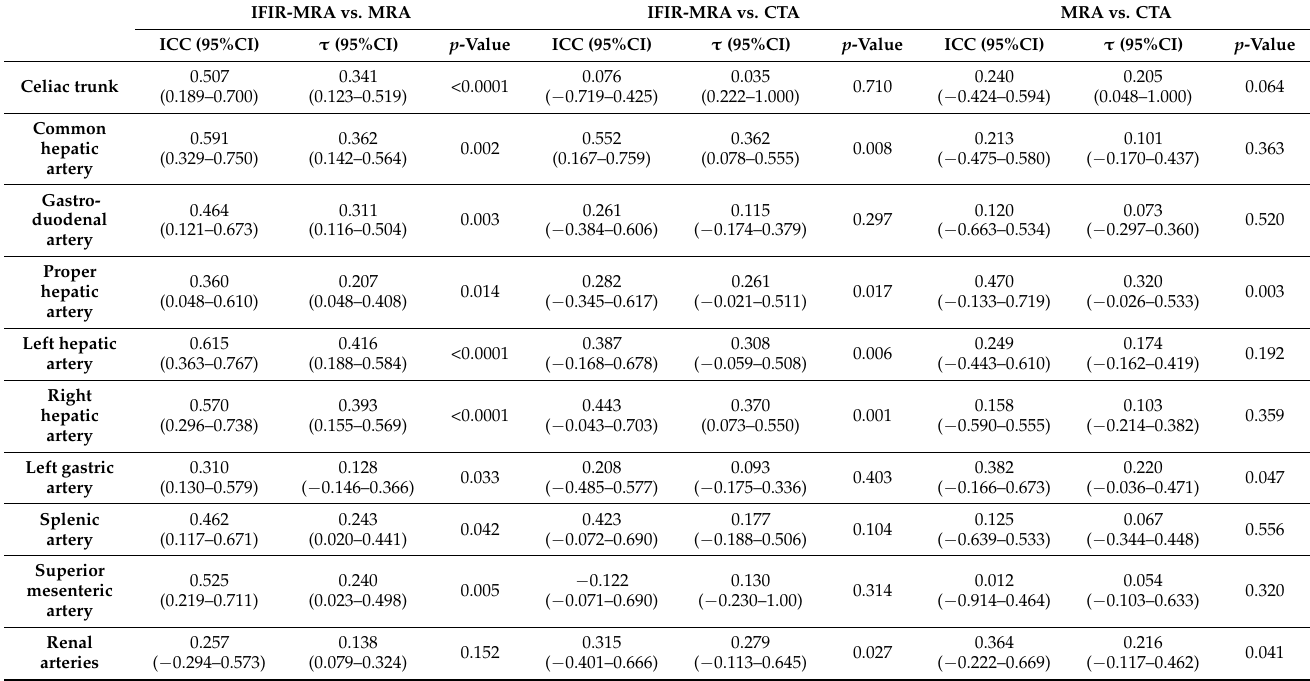
Table 3. ICC values based on absolute-agreement, 2-way mixed-effects model, and Tau correlation coefficients between IFIR-MRA, MRA and